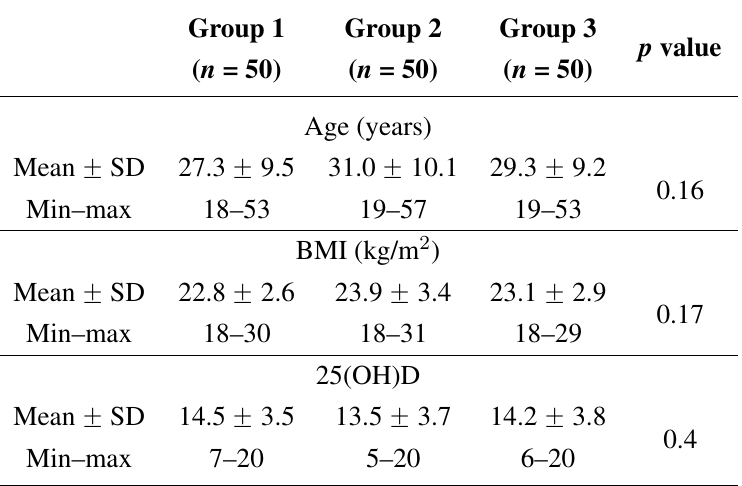
Table 2. Demographic data of the 150 subjects included in the